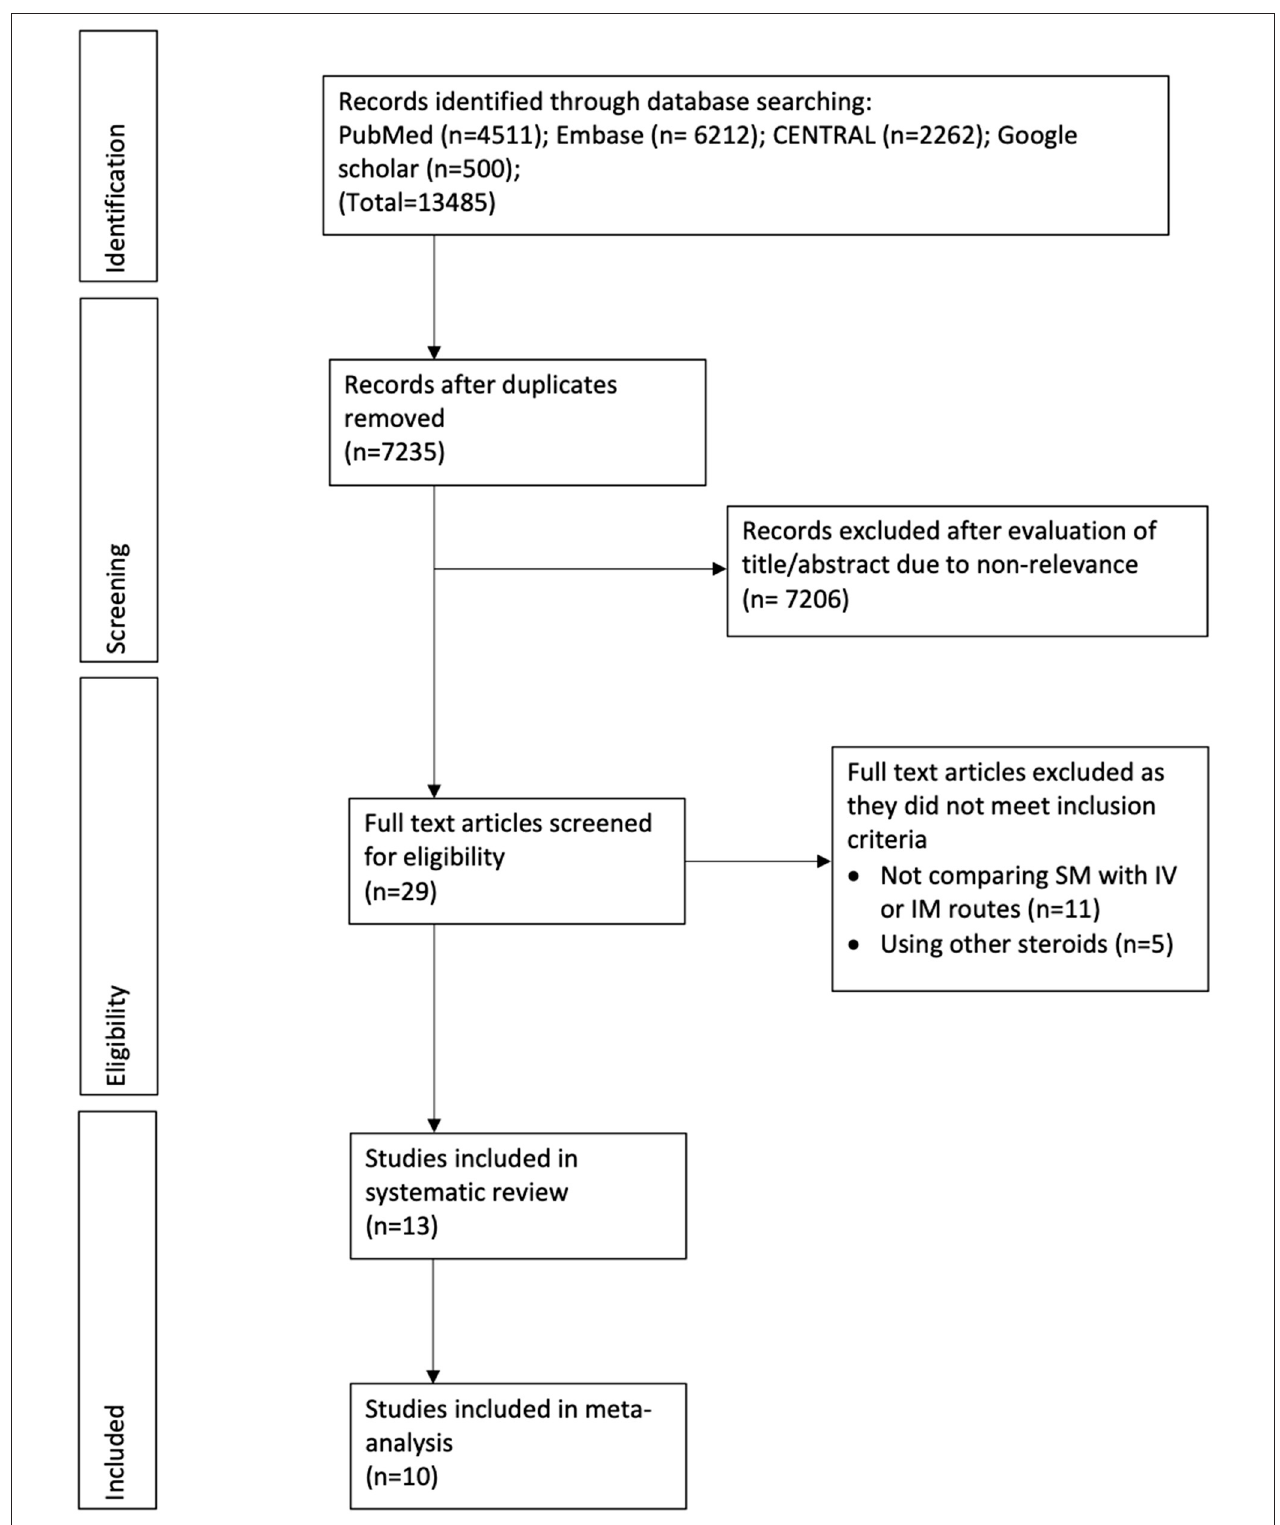
FIGURE 1 | Study flow